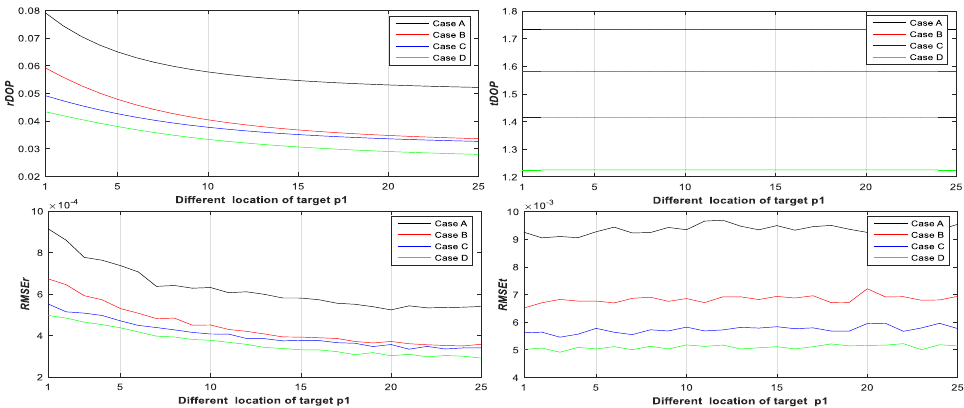
Sensors 2020 , 20 , x FOR PEER REVIEW Figure3. rDOP 1 , tDOP 1 , RMSE r ,1 , and RMSE t ,1 ofCaseA,B,C,andDwithrespecttoonedi ff erenttarget. Figure 3. of Case A, B, C, and D with respect to one different target.